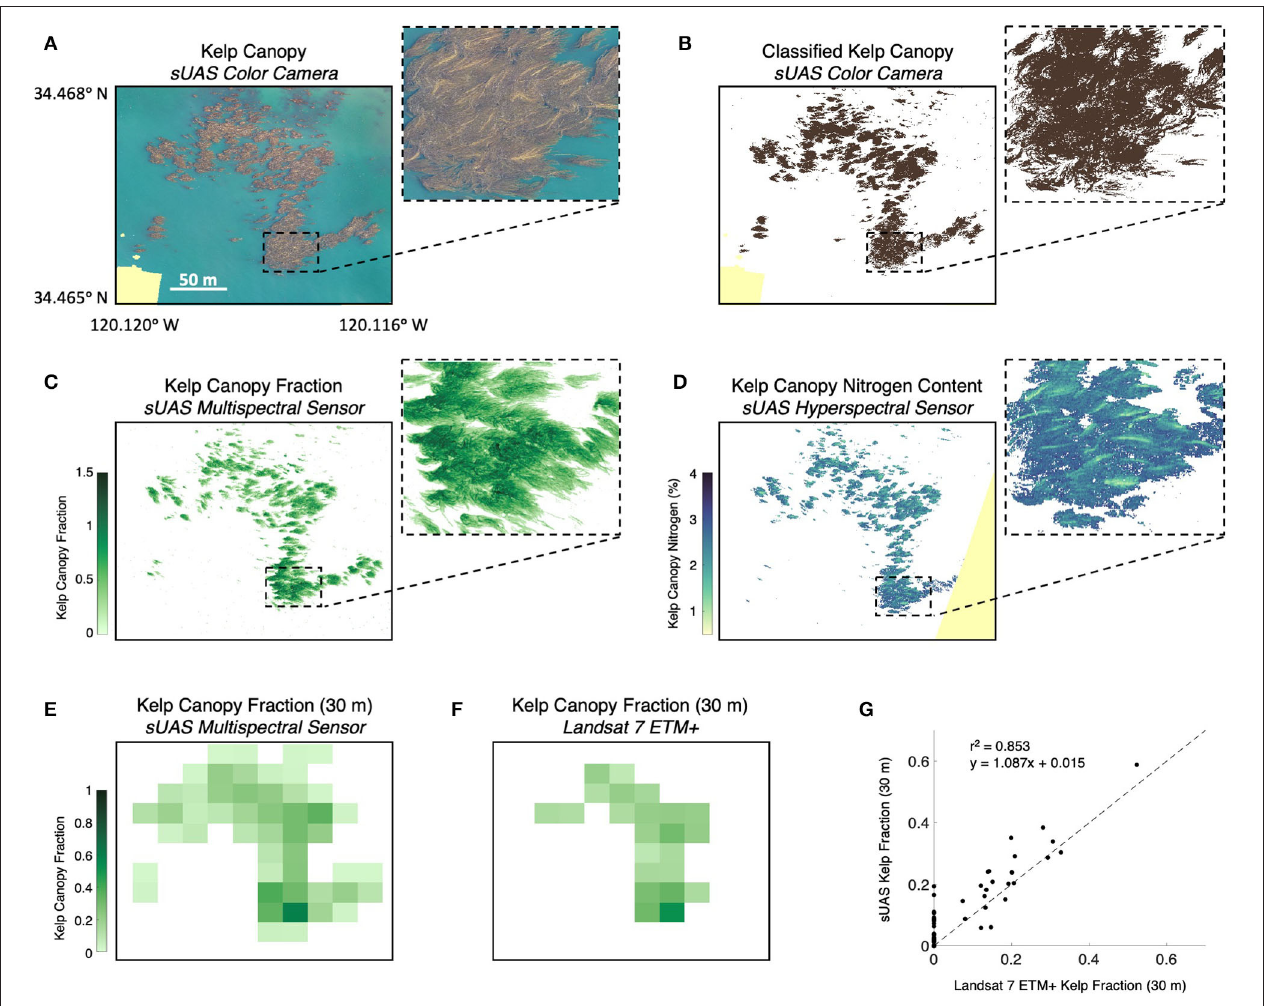
FIGURE 4 | (A) Color orthomosaic of the Arroyo Quemado kelp forest canopy using the color camera on the Phantom 4 Pro sUAS (pixel resolution of 3.2cm). (B) Kelp canopy classified from the color orthomosaic. (C) Fraction of each pixel covered by kelp canopy determined using Multiple Endmember Spectral Mixture Analysis (MESMA) with imagery from the sUAS multispectral sensor (pixel resolution of 6.5cm). (D) Kelp canopy nitrogen content determined using the nitrogen content spectral algorithm with imagery from the sUAS hyperspectral sensor (pixel resolution 25cm). (E) The mean kelp canopy fraction from the multispectral sensor binned into 30m pixels to compare with (F) . Kelp canopy fraction determined from the Landsat 7 ETM + multispectral satellite sensor. (G) Comparison of the kelp canopy fraction from the multispectral sUAS sensor binned into 30m pixels and the Landsat 7 ETM + sensor. Pale yellow color shows areas not imaged by the sensor. All imagery acquired between 9:30a.m. and 12 p.m. local time on June 30,